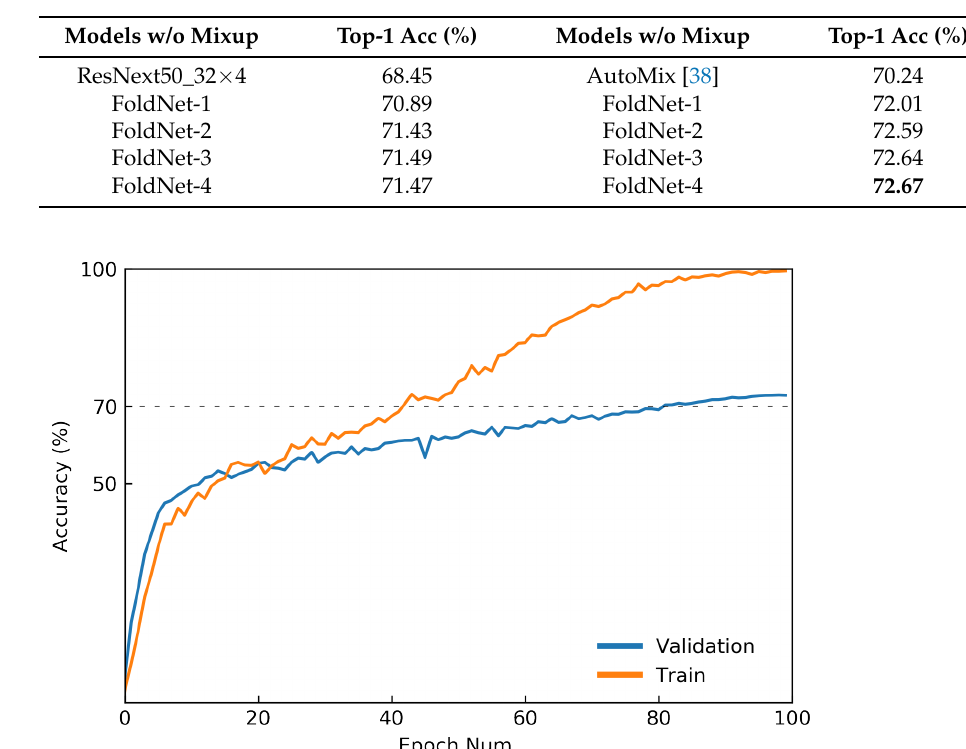
Table 2. Top-1 Acc (%) of image classification on Tiny ImageNet.